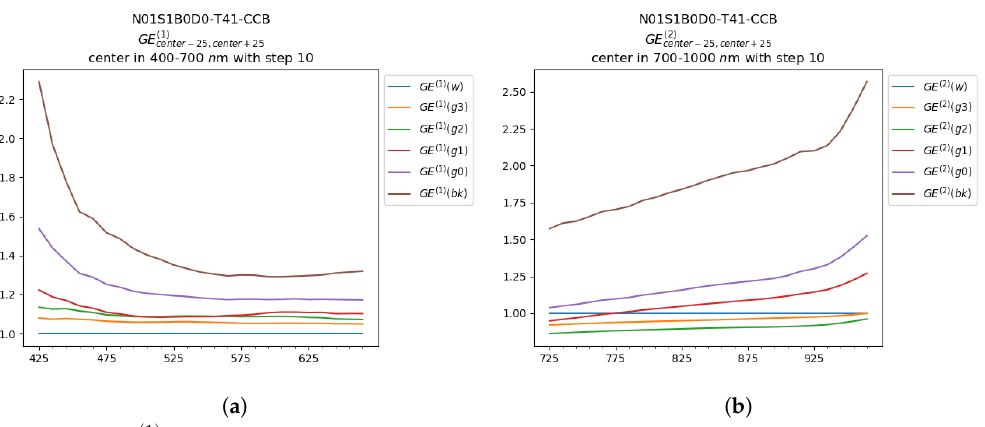
Figure 10. GE ( 1 ) of the CCB of image N01S1B0D0-T41 in ( a ) range 400nm to 700nm and ( b ) in the interval 700nm to 1000nm, both evaluated for each wavelength and smoothed by applying a sliding window.